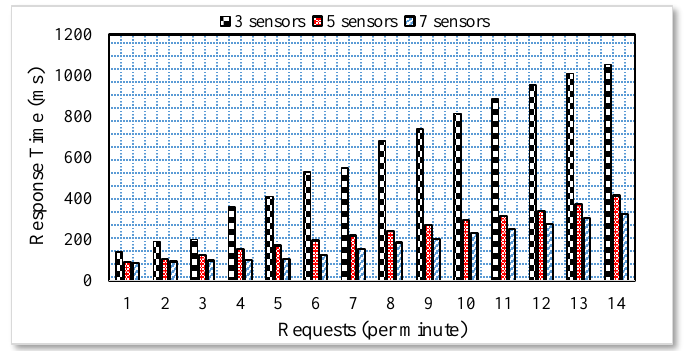
Figure 3. Response time analysis.